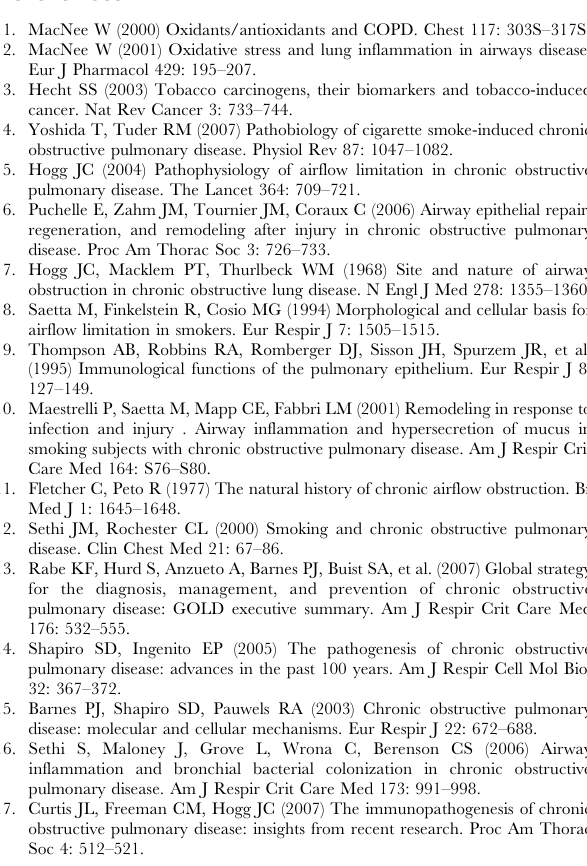
smokers by yellow. B. Principal components analysis of gene expression in COPD smoker, high responder and low responder healthy smokers. Each axis represents one principal component (PC), with PC1 on the x axis and PC2 on the y axis. Low responder healthy smokers are represented by yellow dots, high responder healthy smokers by orange dots and COPD smokers by red dots. Table S1 Identity of validation set subjects. Table S2 Smoking-related differentially expressed genes in the small airway epithelium of healthy nonsmokers and healthy smokers. Table S3 TaqMan confirmation of selected genes. Table S4 Overlap of genes differentially expressed in the SAE of healthy smokers vs nonsmokers with other reported smoking responsive genes. Table S5 Characteristics of the I SAE among the study population. Table S6 Demographics of low responder and high responder healthy smokers.